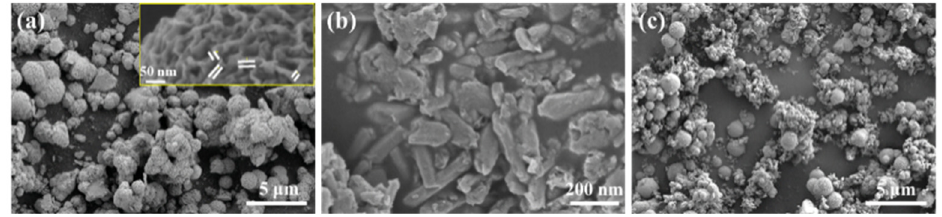
Figure 1. FESEM image of: ( a ) Pure MoS 2 , ( b ) pure Te nanorods, and ( c ) MoS 2 /Te nanocomposite.